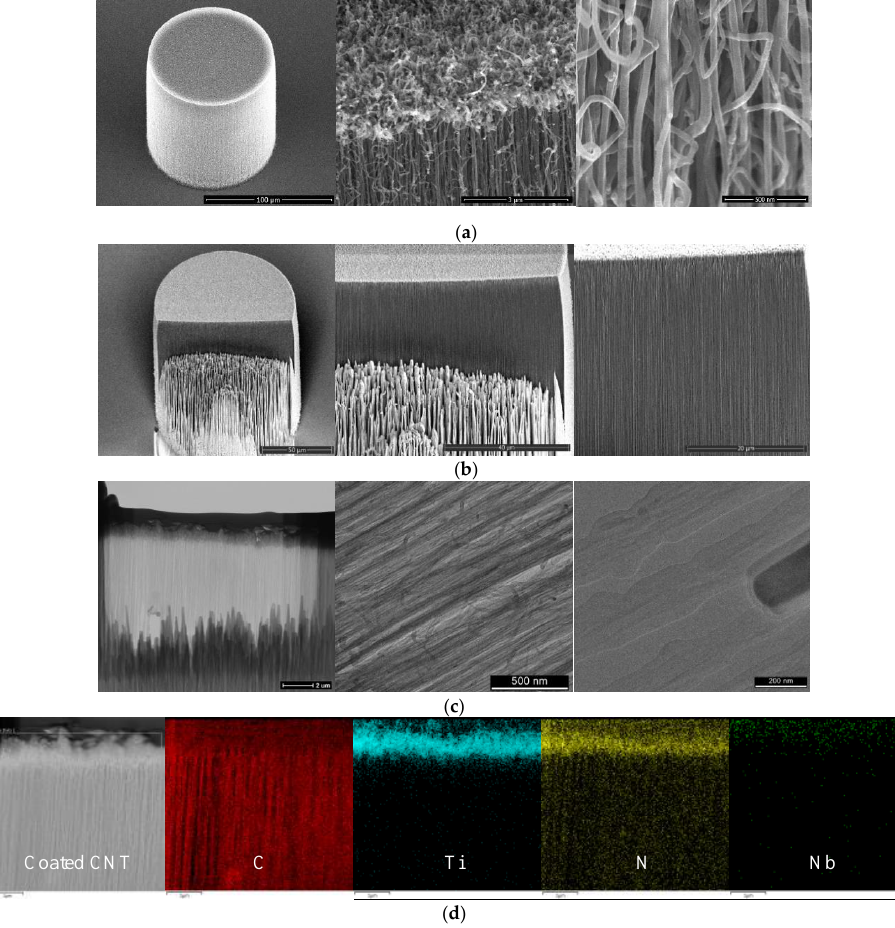
Figure 3. VA-MWCNT pillar with 20 nm NbTiN coated. ( a ) SEM images of coated VA-MWCNT pillar; ( b ) SEM image of FIB on pillar; ( c ) STEM and TEM images of focused ion beam (FIB) prepared lamella; ( d ) energy-dispersive X-ray spectroscopy (EDX) mapping of the